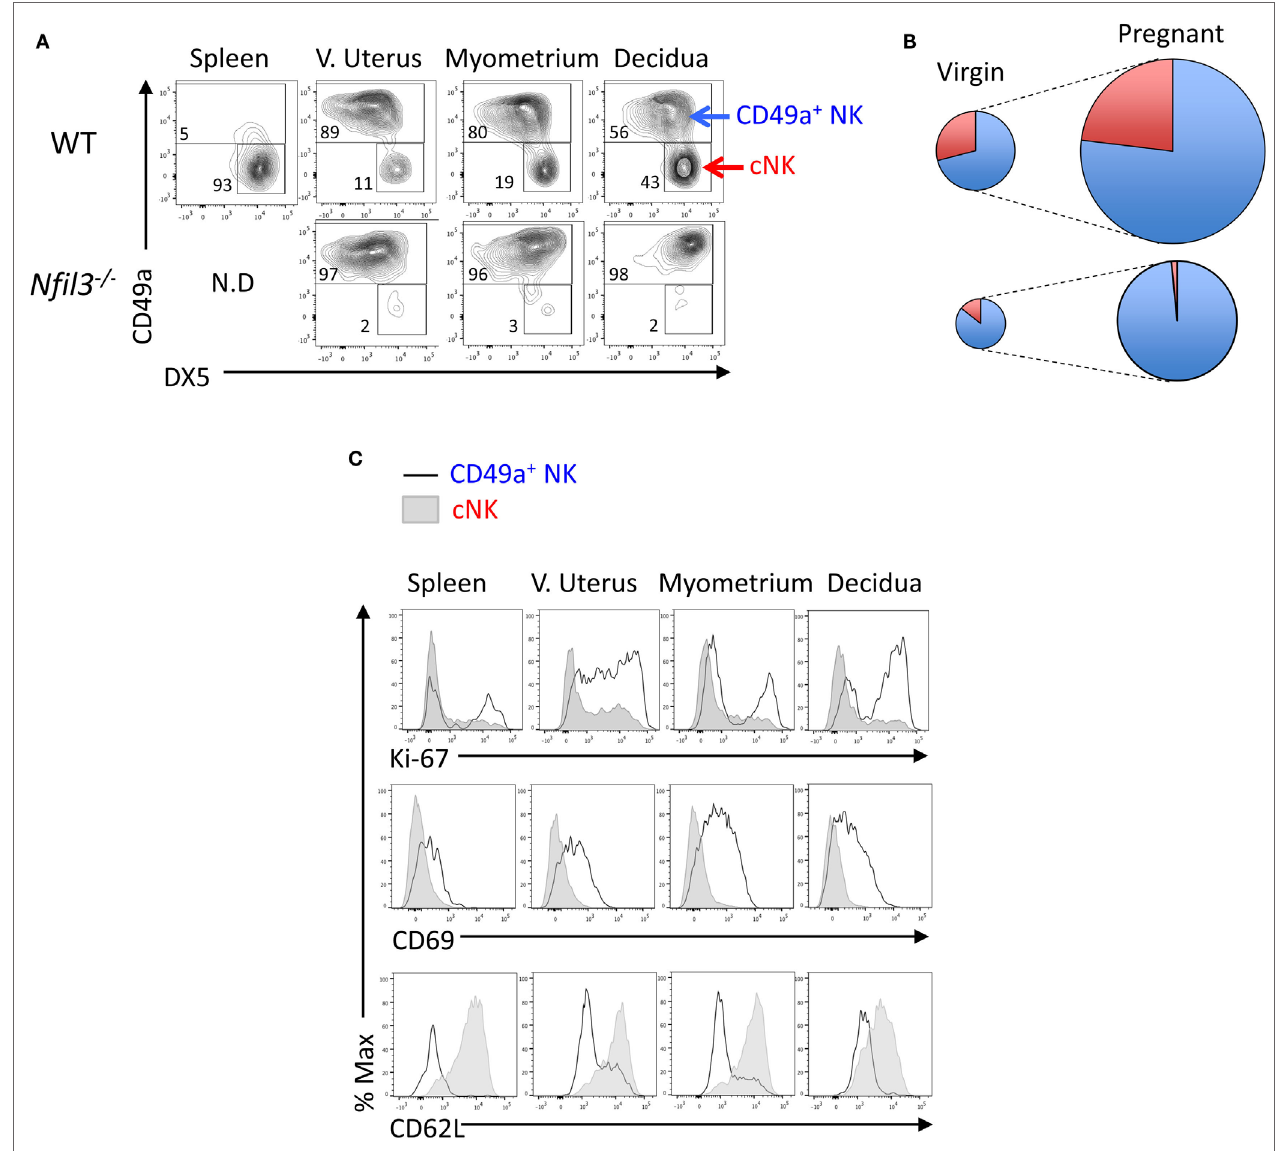
FigUre 1 | reduced expansion of unK cells in Nfil3 − / − dams . (a) Representative flow cytometry plots showing separation of CD45 + CD3 − NK1.1 + NKp46 + NK cells in CD49a + uNK and CD49a − DX5 + (cNK) cells in the indicated tissues in WT and Nfil3 − / − females. (B) Visual representation of composition and expansion of CD49a + uNK (blue) and CD49a − DX5 + cNK (red) in the uterus of virgin and pregnant WT and Nfil3 − / − mice. (c) Representative flow cytometry histograms of intracellular Ki-67, surface CD69 and CD62L in ex vivo CD49a + uNK, and CD49a − DX5 + cNK in the indicated tissues of WT females. Data representative of two to three independent experiments, n = 4–20 mice per